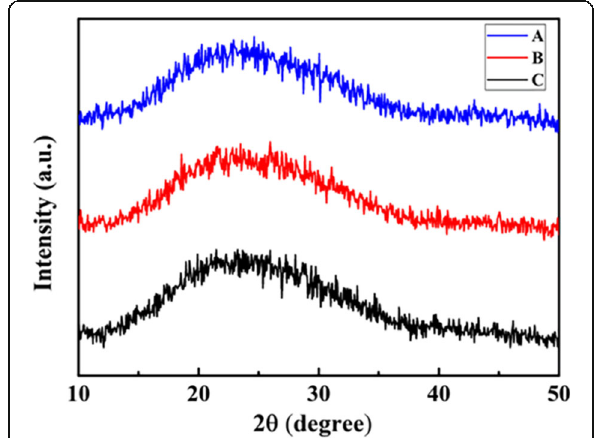
Fig. 3 The XRD curves of different molecular weight ArPTU films (A, B, and C are polythioureas synthesized by the molar ratio PDTC/ MDA (1/1), PDTC/MDA (0.95/1), and PDTC/MDA